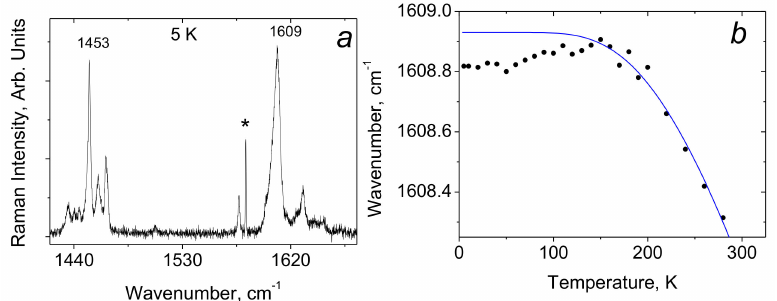
Figure 31. ( a ) The spectrum of ibuprofen (COOH) at 5 K in the range of C = O vibrations. The asterisk marks the position of line of Ne lamp, which was registered at each temperature for correction of the spectra. ( b ) Temperature dependence of the position of the 1609 cm − 1 band peak of the C = O stretching vibration. The solid curve is plotted under the condition that a change in the mode frequency is caused by an activation process with ∆ E = 80